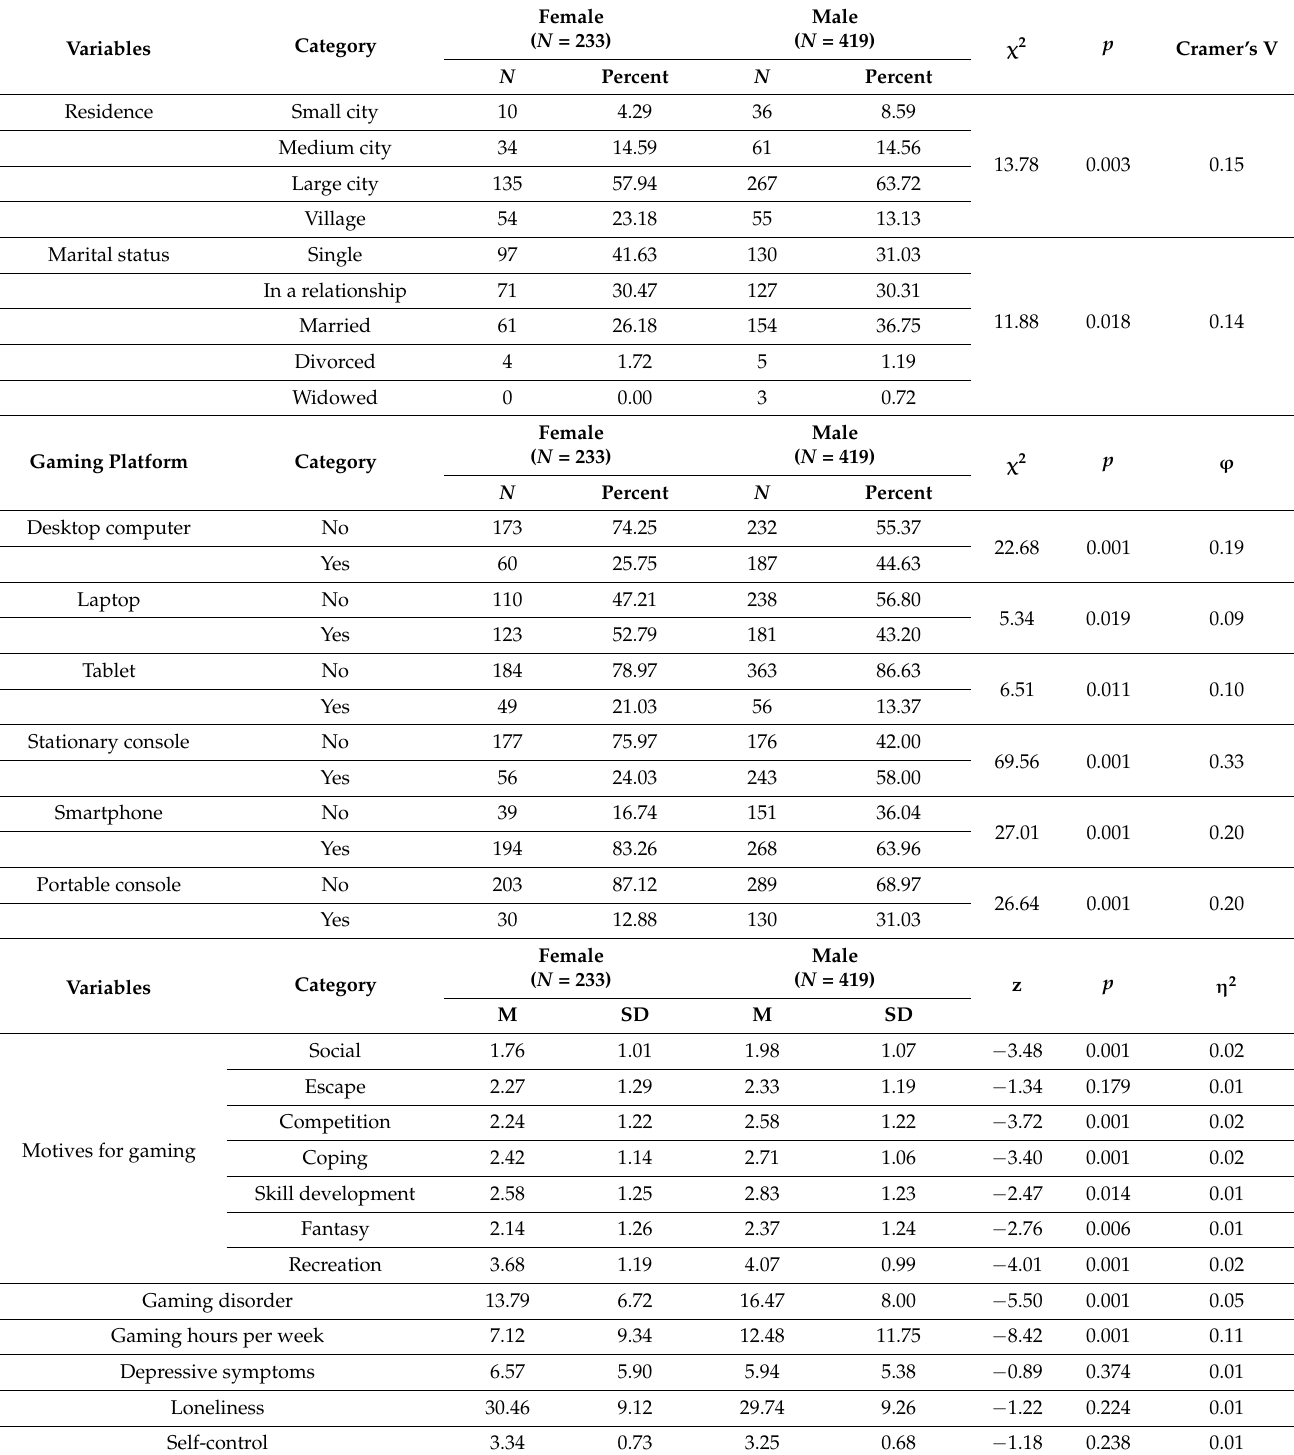
Table 2. Differences between female and male gamers in socio-demographic variables, gaming platform, gaming disorder, motives for gaming, depression symptoms, loneliness, and